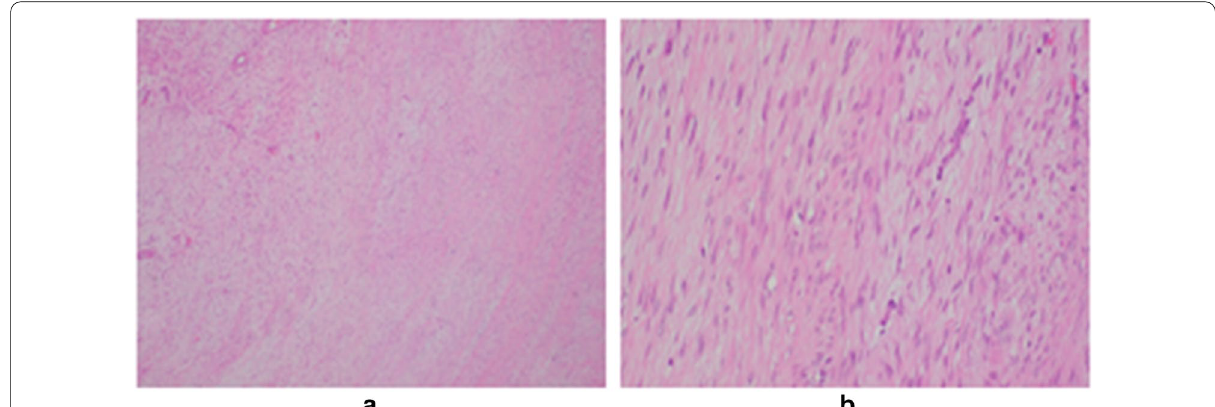
Fig. 4 Haematoxylin and eosin stain demonstrating loosely arranged bundles of spindled fibroblastic/myofibroblastic cells without significant atypia, scattered small-sized thin-walled vessels ( ( 20) ( b ×